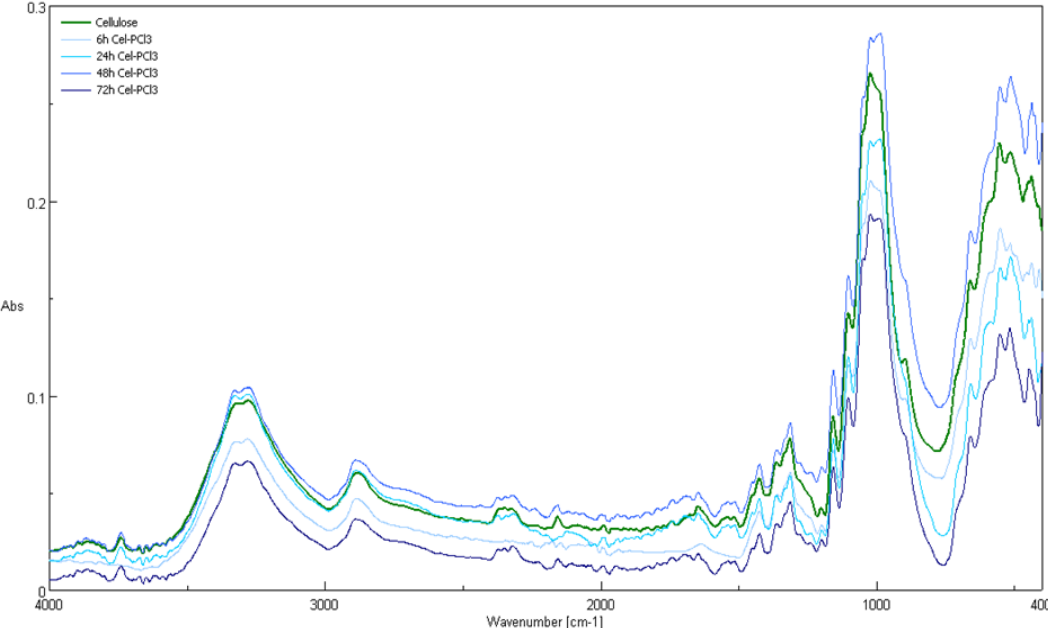
Figure 11. ATR-FTIR spectra of unmodified cellulose and cellulose samples formed during 6 h, 24 h, 48 h, and 72 h of vapour phosphorylation of cellulose by PCl 3 (Cell- O 6 -P(O)(OH)(h)). Table 6. Characterization of FTIR spectra of glucose, cellulose, glucose-phosphate, and cellulose-phosphates. Compound/Frequency [cm - 1 ].